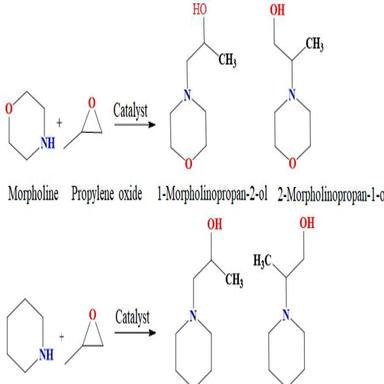
XRD pattern of a sulfonic acid functionalized mesoporous materials, b Zn complex incorporated ordered mesoporous materials. (A) MCM-41, (B) MCM-48, (C) SBA-15.